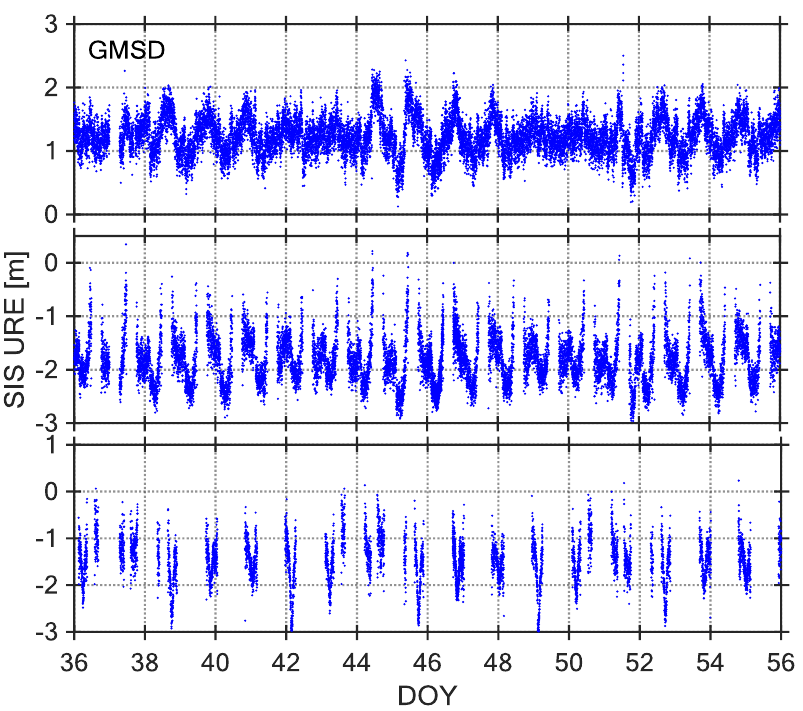
Figure 5. SIS-URE time series of Station GMSD, C04 ( top ), C09 ( middle ) and C14 ( bottom ), DOY 036–056, 2017.